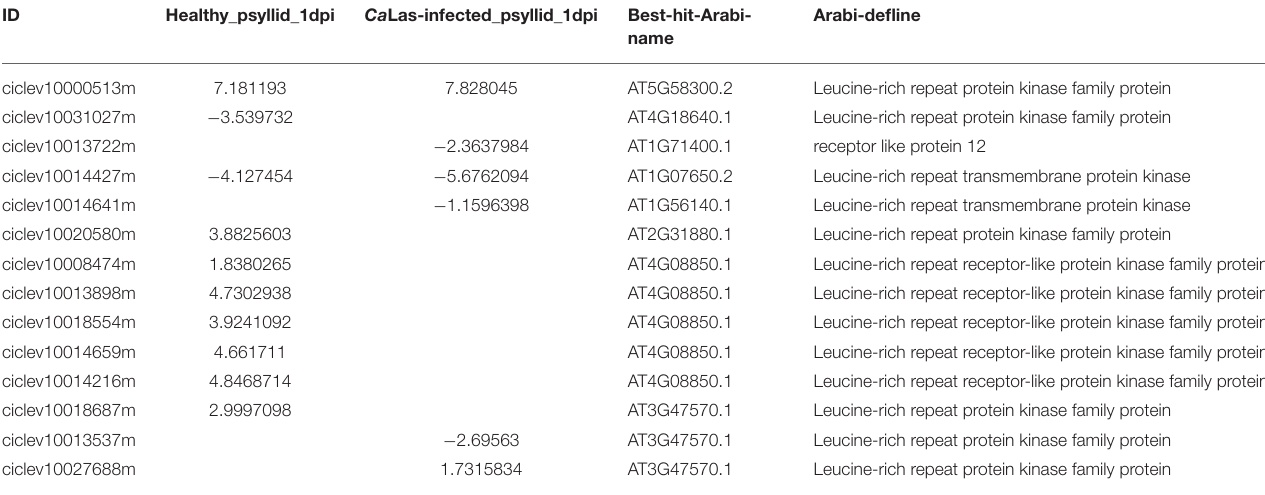
TABLE 3 | The modulated RLKs/RLP identified in VAL under healthy and Ca Las-infected psyllid infestation at 1